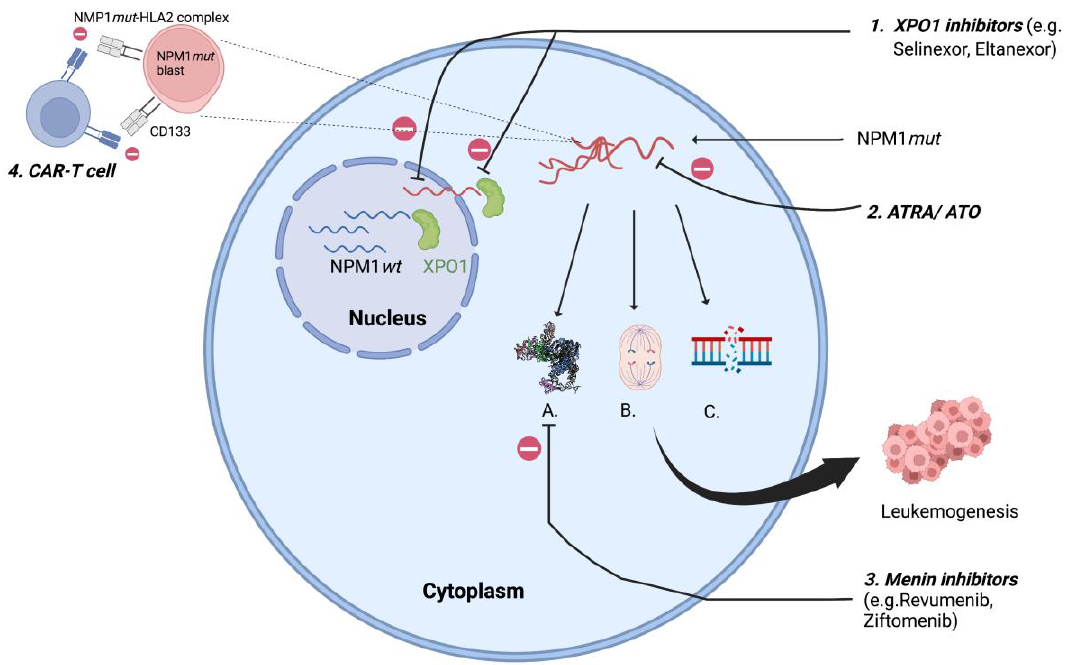
Figure 1. XPO1 transports NPM1 mut to cytoplasm resulting in A. Homeobox (HOX) overexpression; B. Centrosome duplication; C. defective DNA repair resulting in leukemogenesis; 1. XPO1 inhibitors: inhibits XPO1 mediated cytoplasmic export of NPM1 mut ; 2. ATRA/ ATO: oxidative injury and apoptosis of NPM1 mut cells; 3. Menin inhibitors: suppresses HOX by inhibiting menin- KMT2A complex; 4. CAR-T cell: targets NPM1 mut -HLA2 complex, CD133. XPO1- exportin 1; ATRA/ATO- all-trans retinoic acid/arsenic trioxide. (Figure created using BioRender).